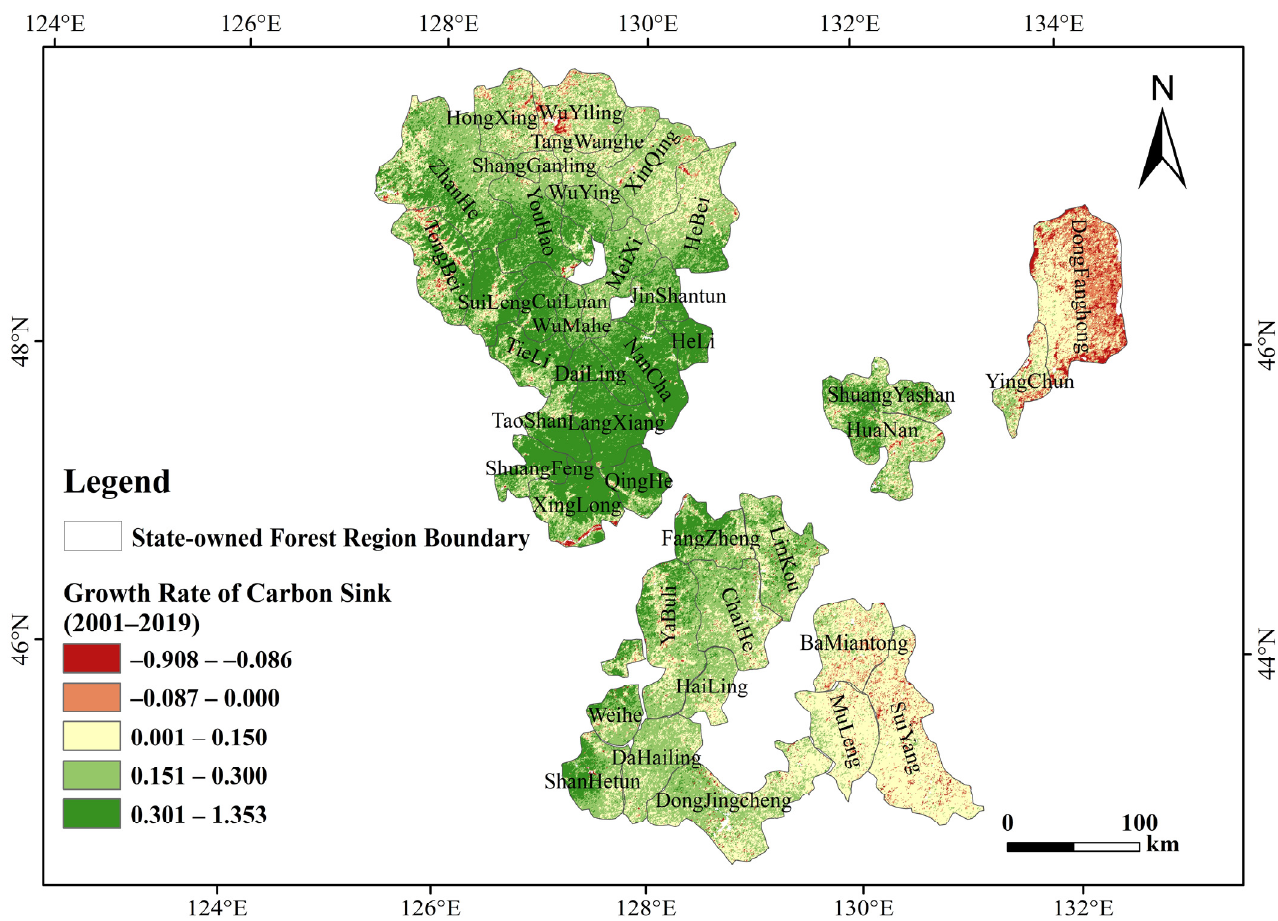
Figure 4. The growth rate of carbon sinks in the key SOFRs in Heilongjiang Province from 2001 to 2019.